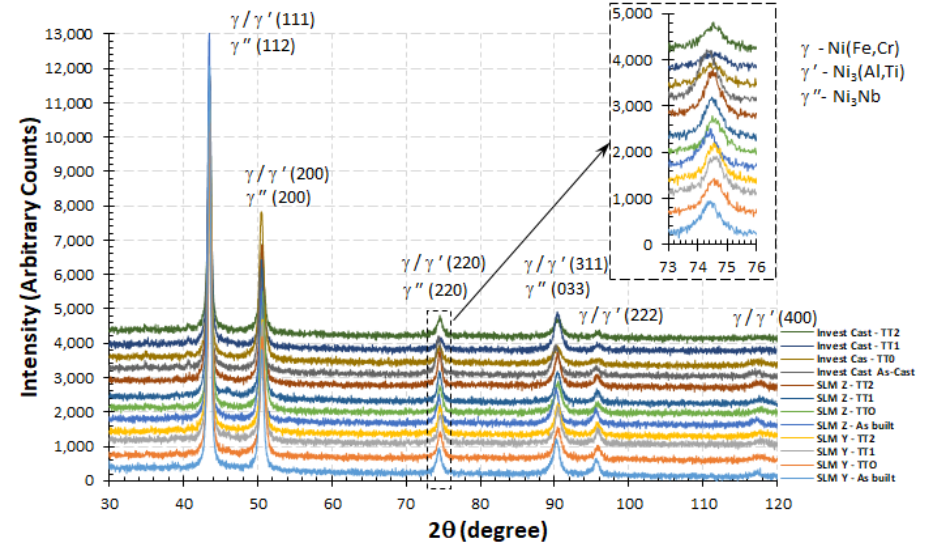
Figure 15. X — Ray diffraction patterns of IN718 powder, SLM, and investment casting samples. Figure 15. X—Ray diffraction patterns of IN718 powder, SLM, and investment casting samples.